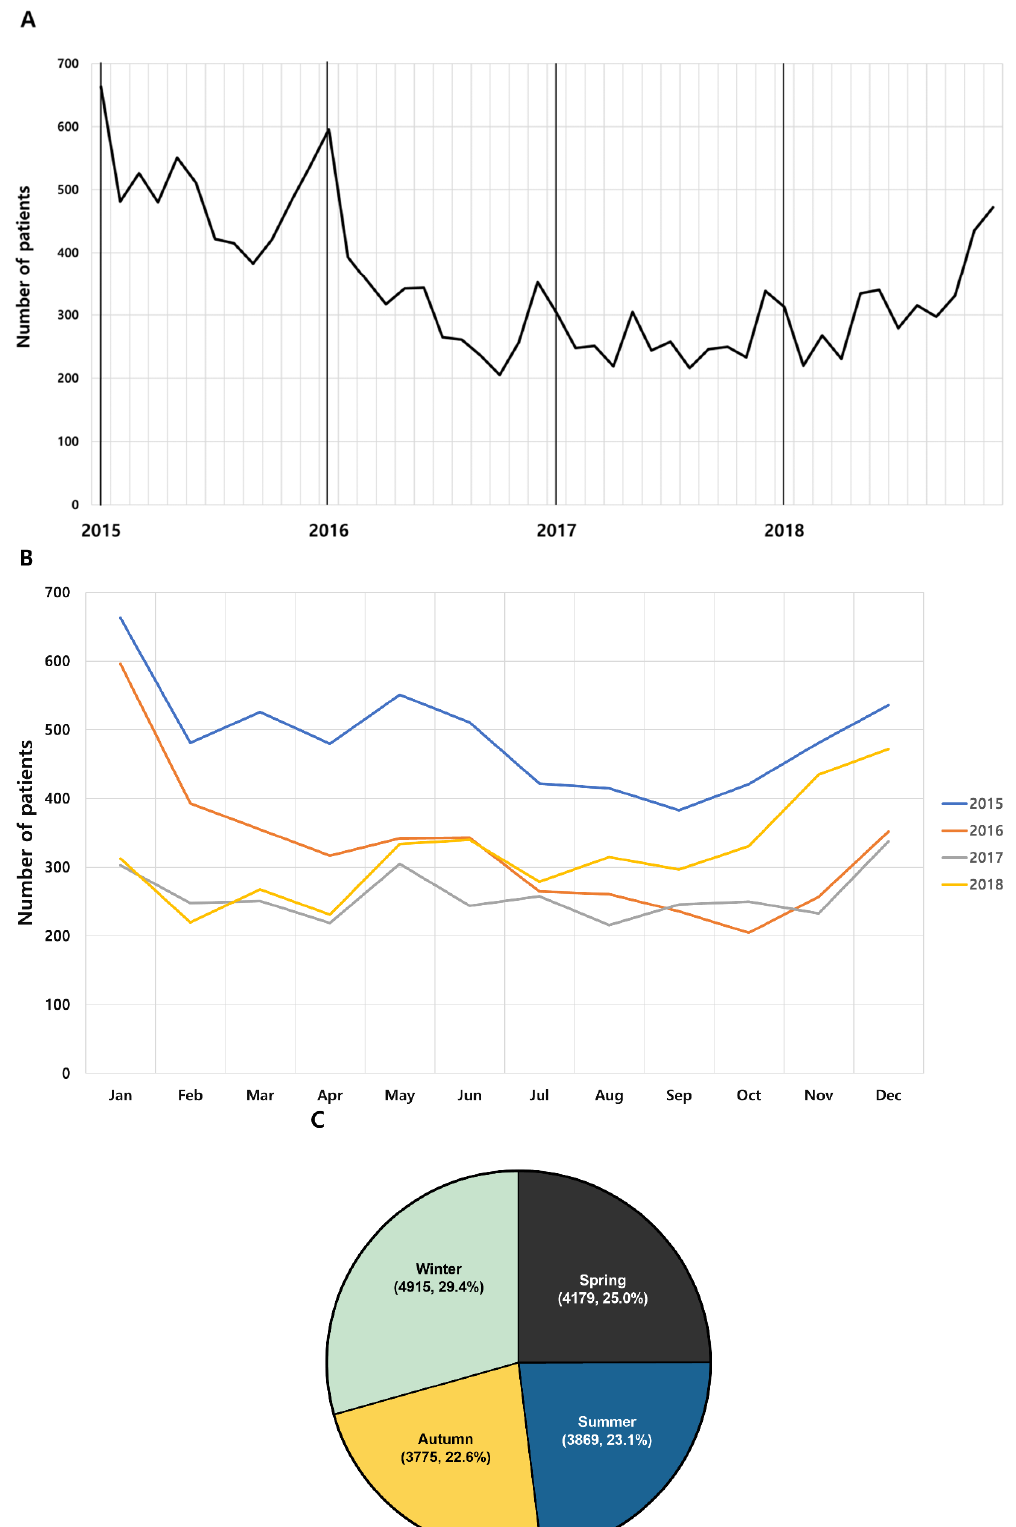
Figure 2. Incidence trend of Kawasaki disease from 2015 to 2018. ( A ) Monthly trend analysis Kawasaki disease from 2015 to 2018. ( B ) Monthly trend analysis of Kawasaki disease according to year. ( C ) Seasonal trend Kawasaki disease incidence. Spring (March to May), summer (June to August), autumn (September to November) and winter (December to February). (Cumulative incidence for 4 years,